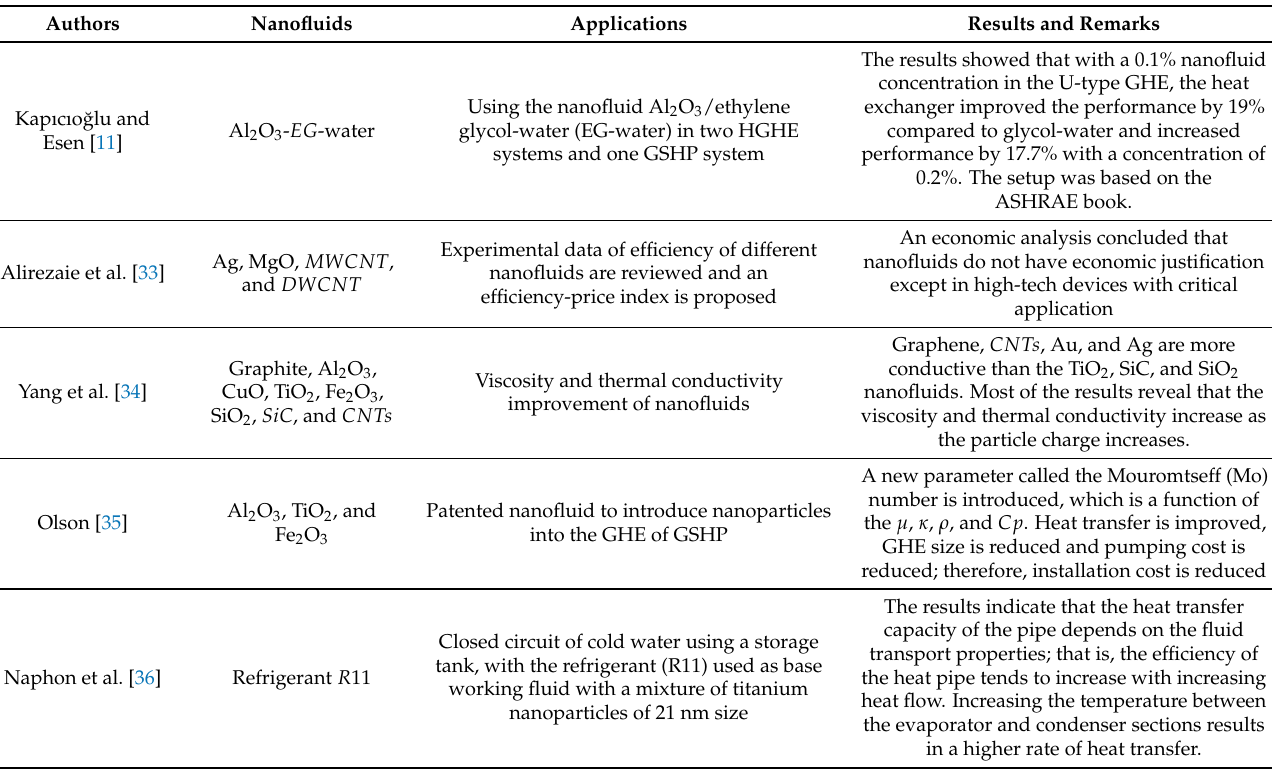
Table 3. Summary of experimental studies on heat exchanger pipes using